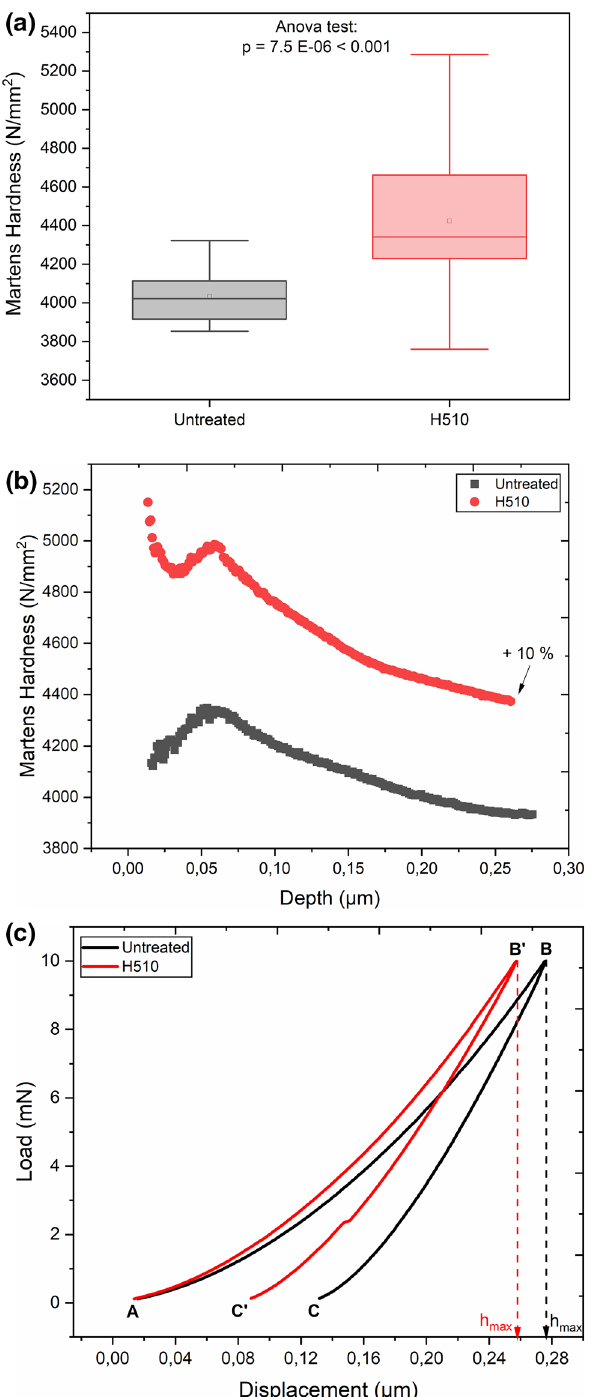
Figure 2. (a) Statistical analysis of hardness of untreated and heat-treated glass surfaces at a load of 10 mN for 16 indentations performed across an array of 4 × 4. The p-value reported by ANOVA test indicates that the means are significantly different at the 0.001 level. (b) Comparative illustration of the mean of variation in hardness as a function of depth from the untreated and heat-treated SLS glass surfaces. The indentation size effect (ISE) due to dislocation strengthening necessary to accommodate plastic deformation, in addition to friction between the indenter and specimen surface 39,40 , may not be neglected at shallow depths below 100 nm. The Martens hardness in the ordinate (y-axis) contains an axis-break. (c) Corresponding mean load–displacement curves illustrating the loading cycle (AB: untreated and AB’: H510) and unloading cycle representative of elastic recovery (BC: untreated and B’C’: H510). The serration observed in the unloading cycle (B’C’) of the H510 specimen reflects local relaxation processes during elastic recovery, which is predominantly more active during the unloading process than during loading 41